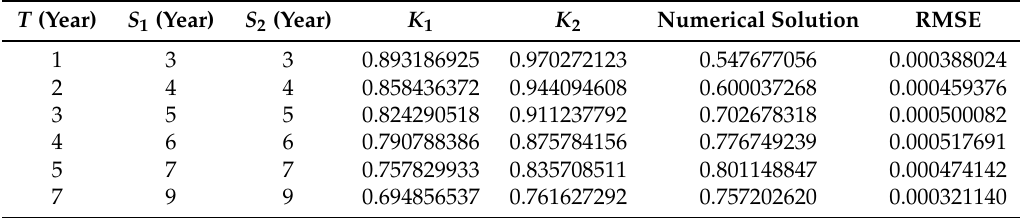
Table 4. Computational results of the two-asset numerical